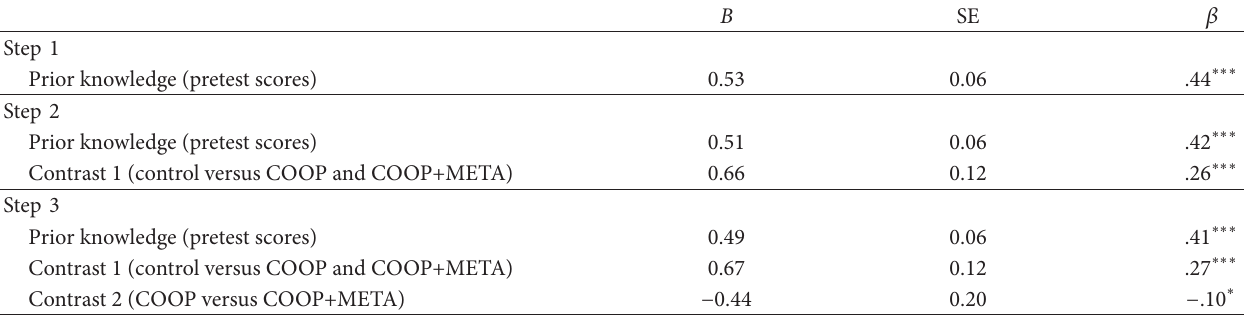
T 5: Multiple regression predicting posttest performance on “developing and evaluating solutions” (scale 2) by prior knowledge and treatment condition.